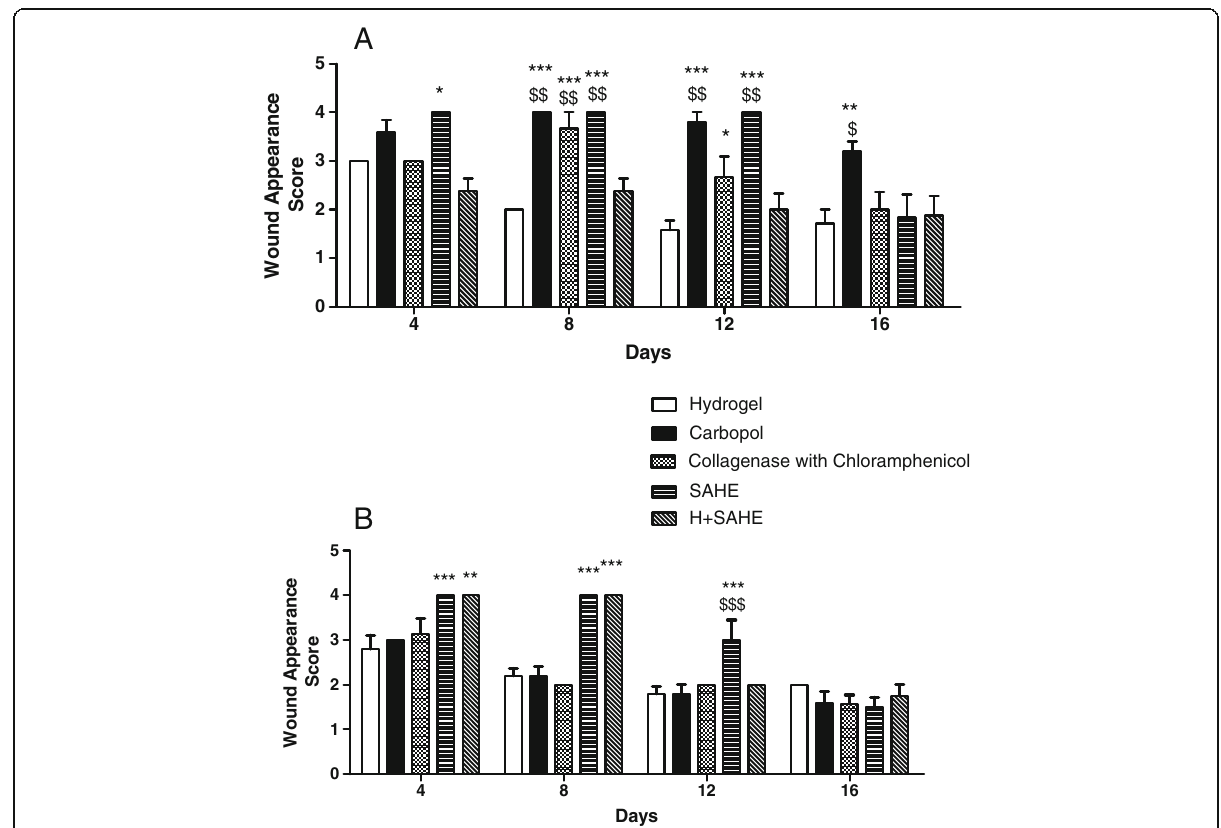
Fig. 5 The wound appearance scores of the cutaneous wounds in the non-diabetic animals ( a ), and in the diabetic animals ( b ), on days 4, 8, 12, and 16. Each column represents the mean ± standard error of 4 – 8 animals, * p < 0.05, ** p < 0.01, *** p < 0.001, represents the level of significance when compared to the Hydrogel group; and $$ p < 0.01 and $$$ p < 0.001 represents the level of significance when compared to the H + SAHE